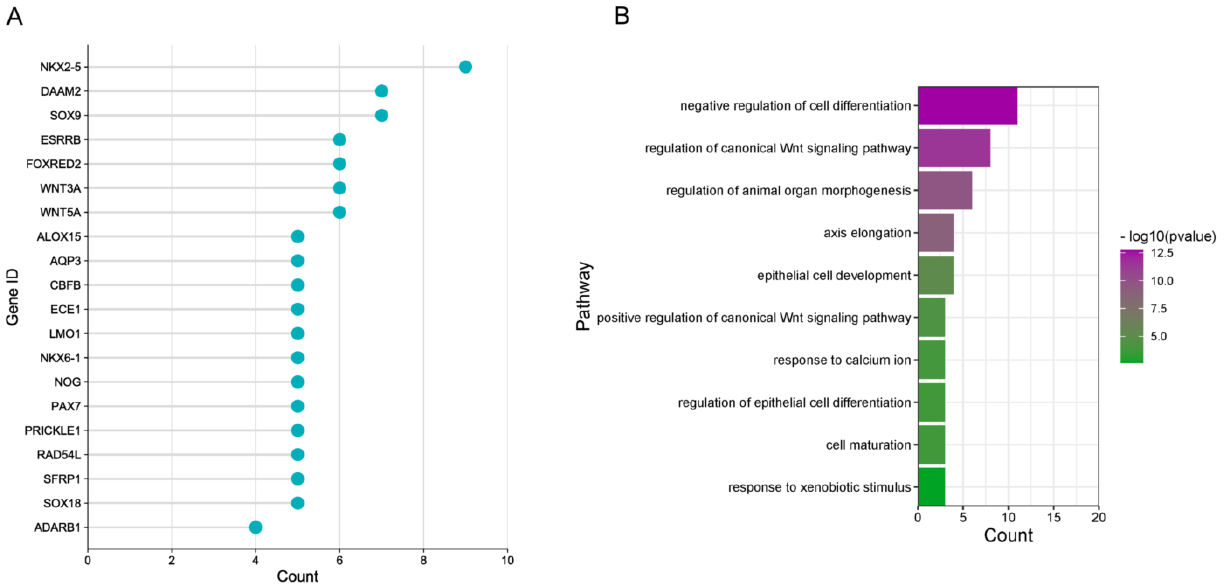
Figure 5. GSEA revealed significant enrichment of pathways related to cell differentiation and Wnt signaling. ( A ) The top 20 leading genes across the different enriched pathways based on frequency in HER2 − vs. HER2+ CRC patients, and ( B ) the related pathways are shown.